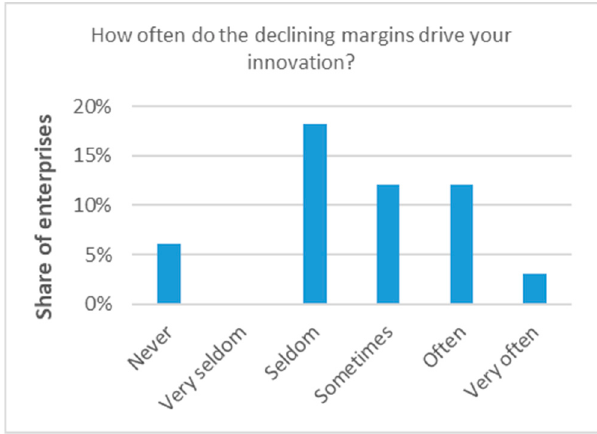
Figure 11. Role of decreasing profit margins in promoting innovation.